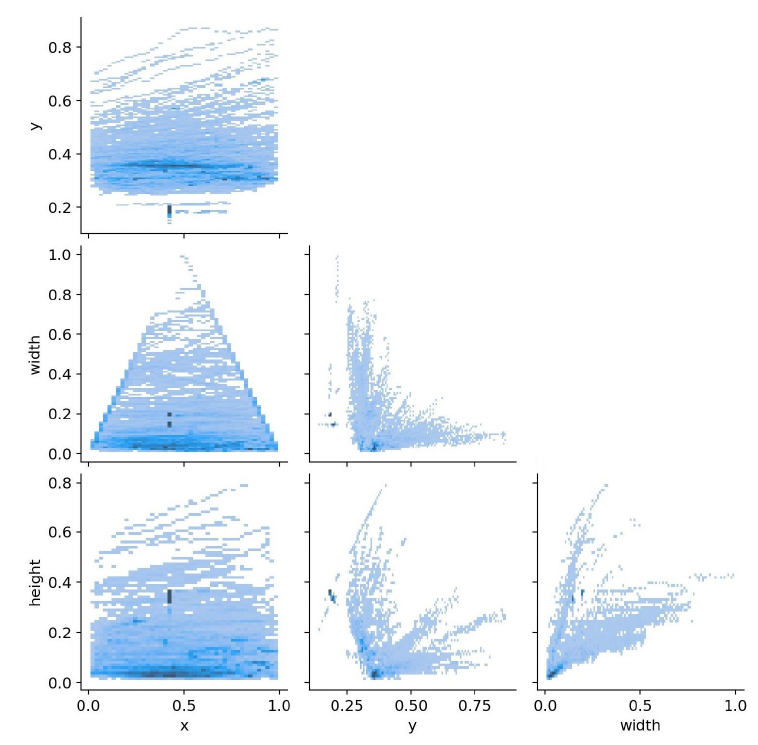
Figure 8. 2D correlogram of annotation positions versus sizes.